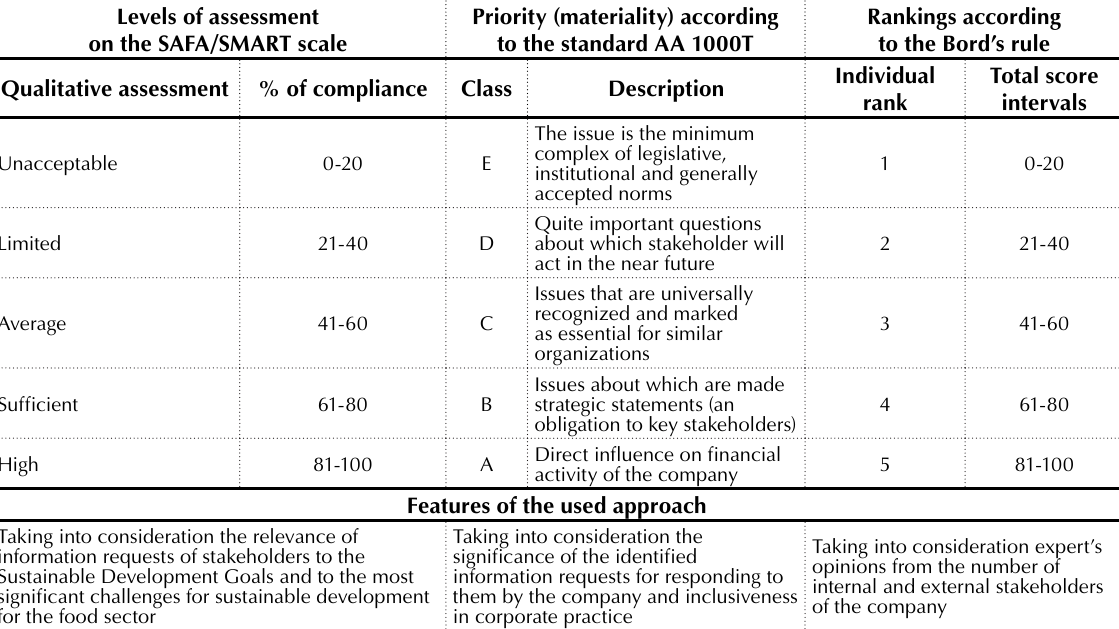
Table 5. Interpretation of ranked and prioritized stakeholder information requests in the food production